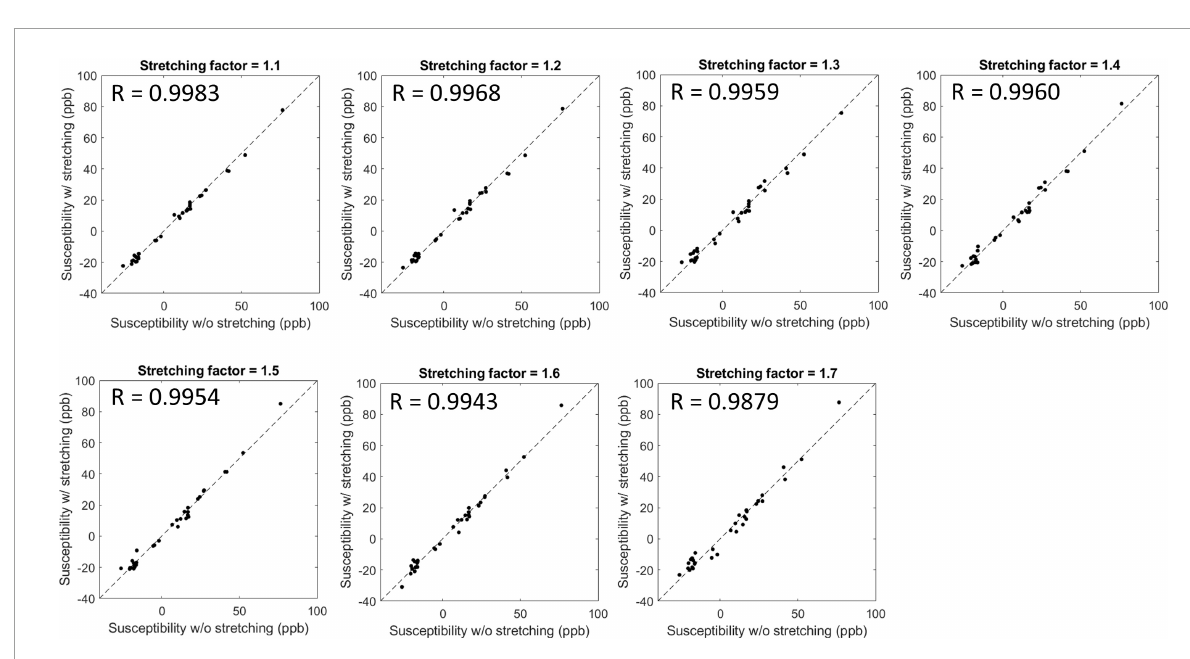
FIGURE4 Scatter plots and Pearson’s correlation between susceptibility values estimated without and with stretched cones trajectories. The estimated susceptibility showed a high linear correlation with a stretching factor up to 1.7 with R > 0.98 and p -value < 0.05.